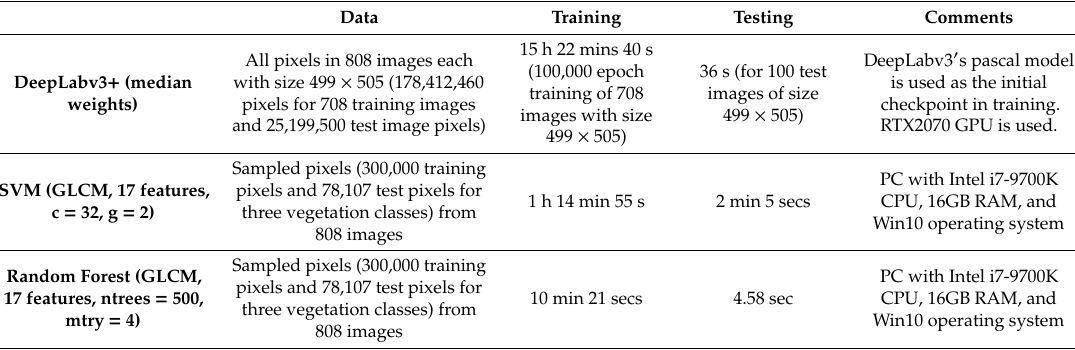
Table 26. Approximate computation times of the three classification methods for three-class Slovenia dataset. Data Training Testing